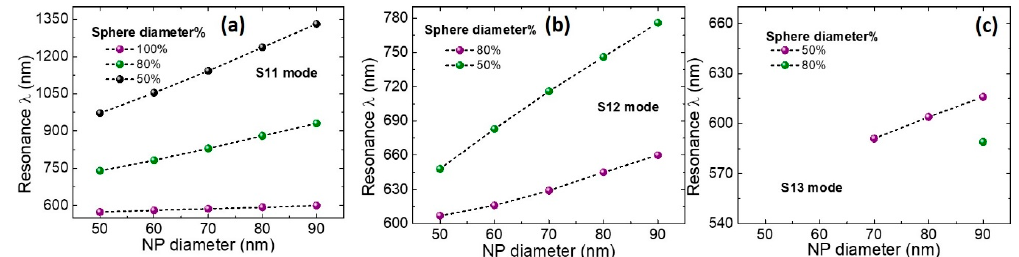
Figure 5. Extracted resonance wavelengths for S11 mode ( a ), S12 mode ( b ), and S13 mode ( c ) obtained from broadband | E / E 0 | 4 spectrum of Figure 4a–c.